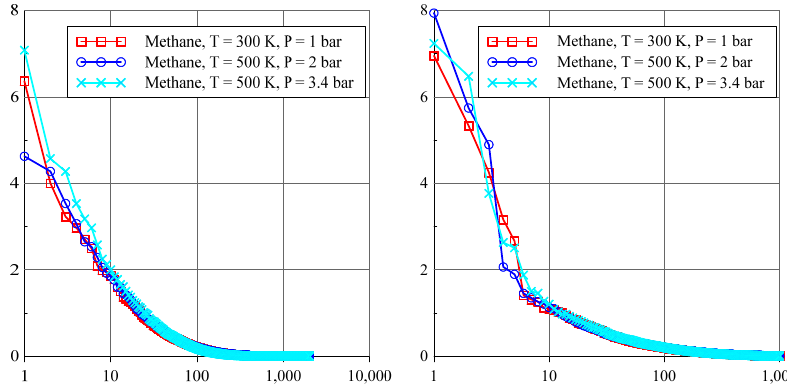
Figure 11. POD spectra of the LES velocity snapshots for vertical ( left ) and horizontal cross-sections of the flow at 1D ( right ).